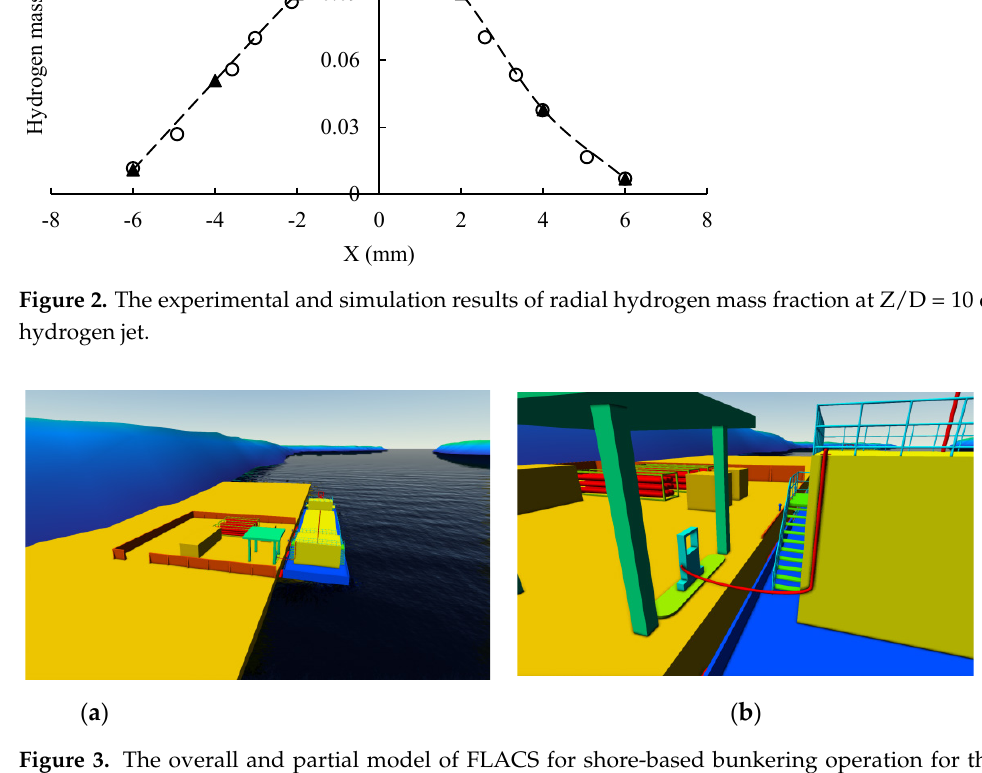
Figure 2. The experimental and simulation results of radial hydrogen mass fraction at Z/D = 10 of hydrogen jet.